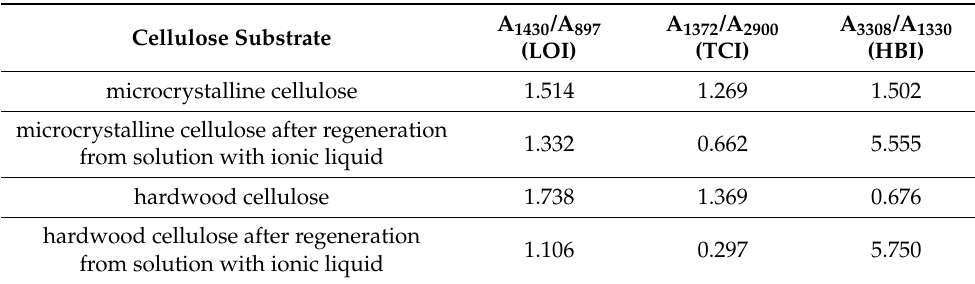
Table 2. Some indexes calculated from spectral data for cellulose substrates, initial and after regener- ation from ionic liquid solution (re-drawn with permission from